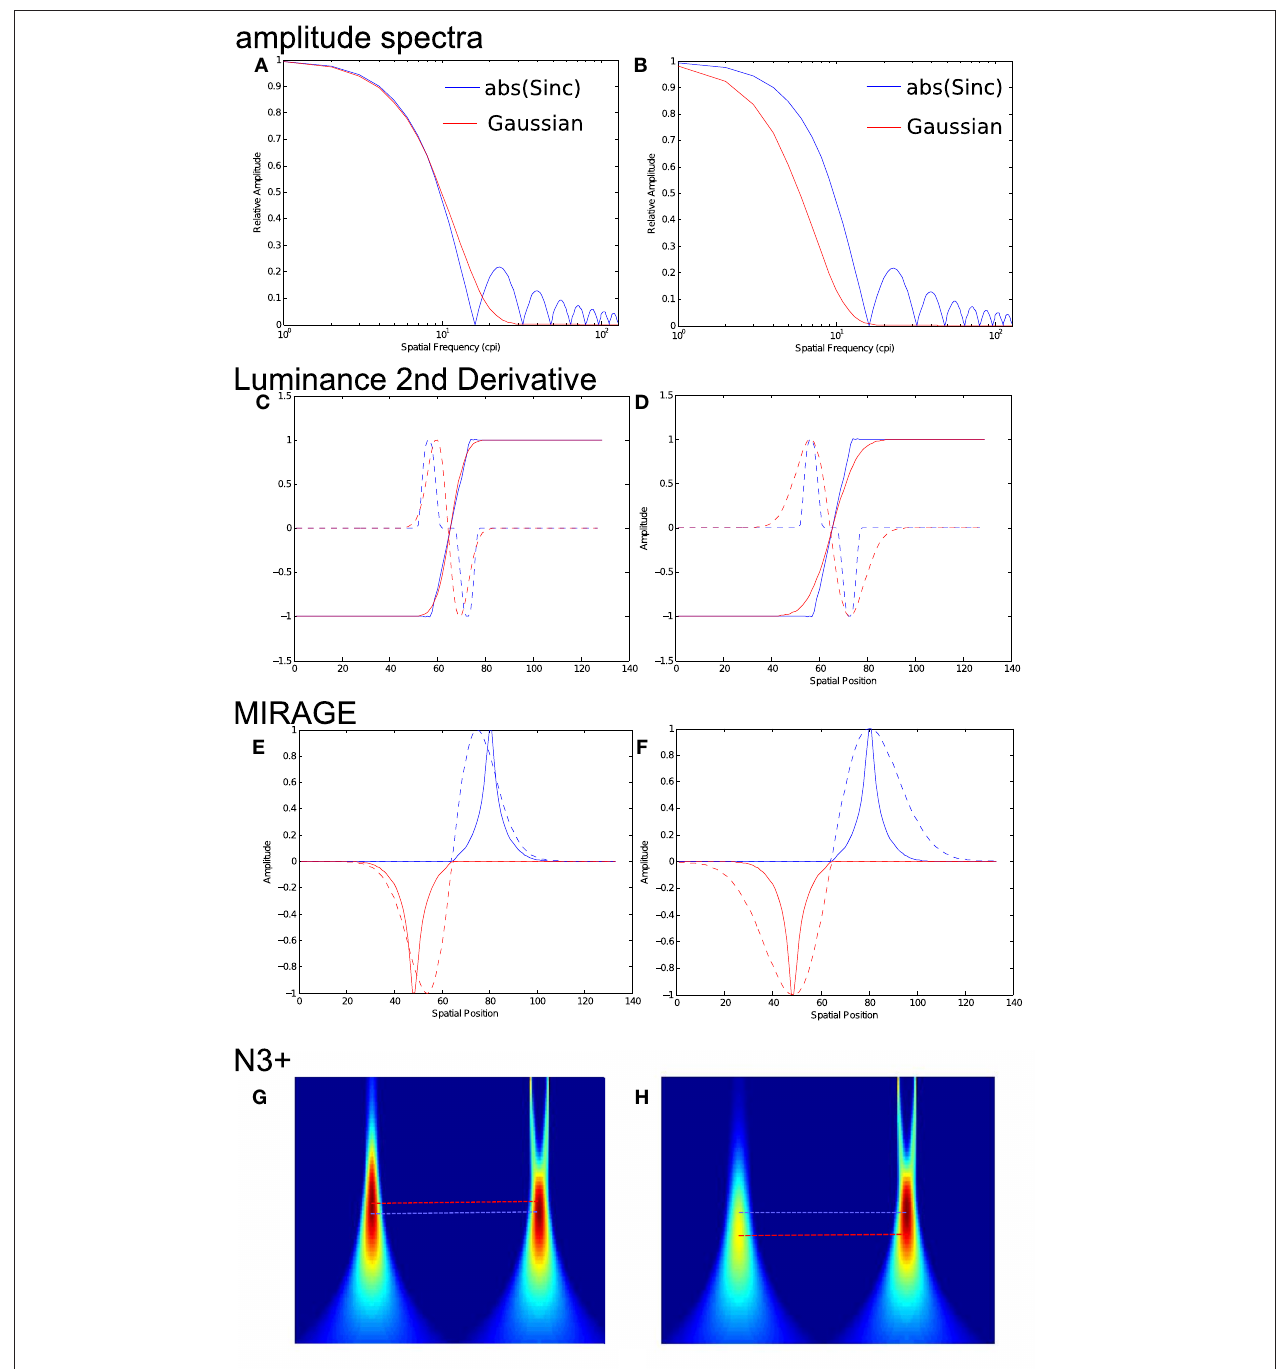
Figure 4 | illustration of four methods for the calculation of apparent blur: Amplitude spectrum, second derivative of luminance, MirAge and N3 + . (A) The amplitude spectrum of a Sinc filter (blue curve, absolute valued with λ = 16 cpi) and the best-fitting Gaussian (red curve, σ = 8.1 cpi). (B) The same Sinc filter (blue curve, real valued λ = 16 cpi) and a more blurring Gaussian (red curve, σ = 5 cpi). (C) Convolution of a step edge with the filters in (A) produces blurred edges ( C , solid curves) with similar peak slopes, but with second spatial derivatives ( C , dashed curves) and zero bounded regions (ZBRs e , dashed curves) in MIRAGE whose peaks are closer together for the Gaussian- than the Sinc-blurred edge. (g) The peak responses of the N3 + model differs for the